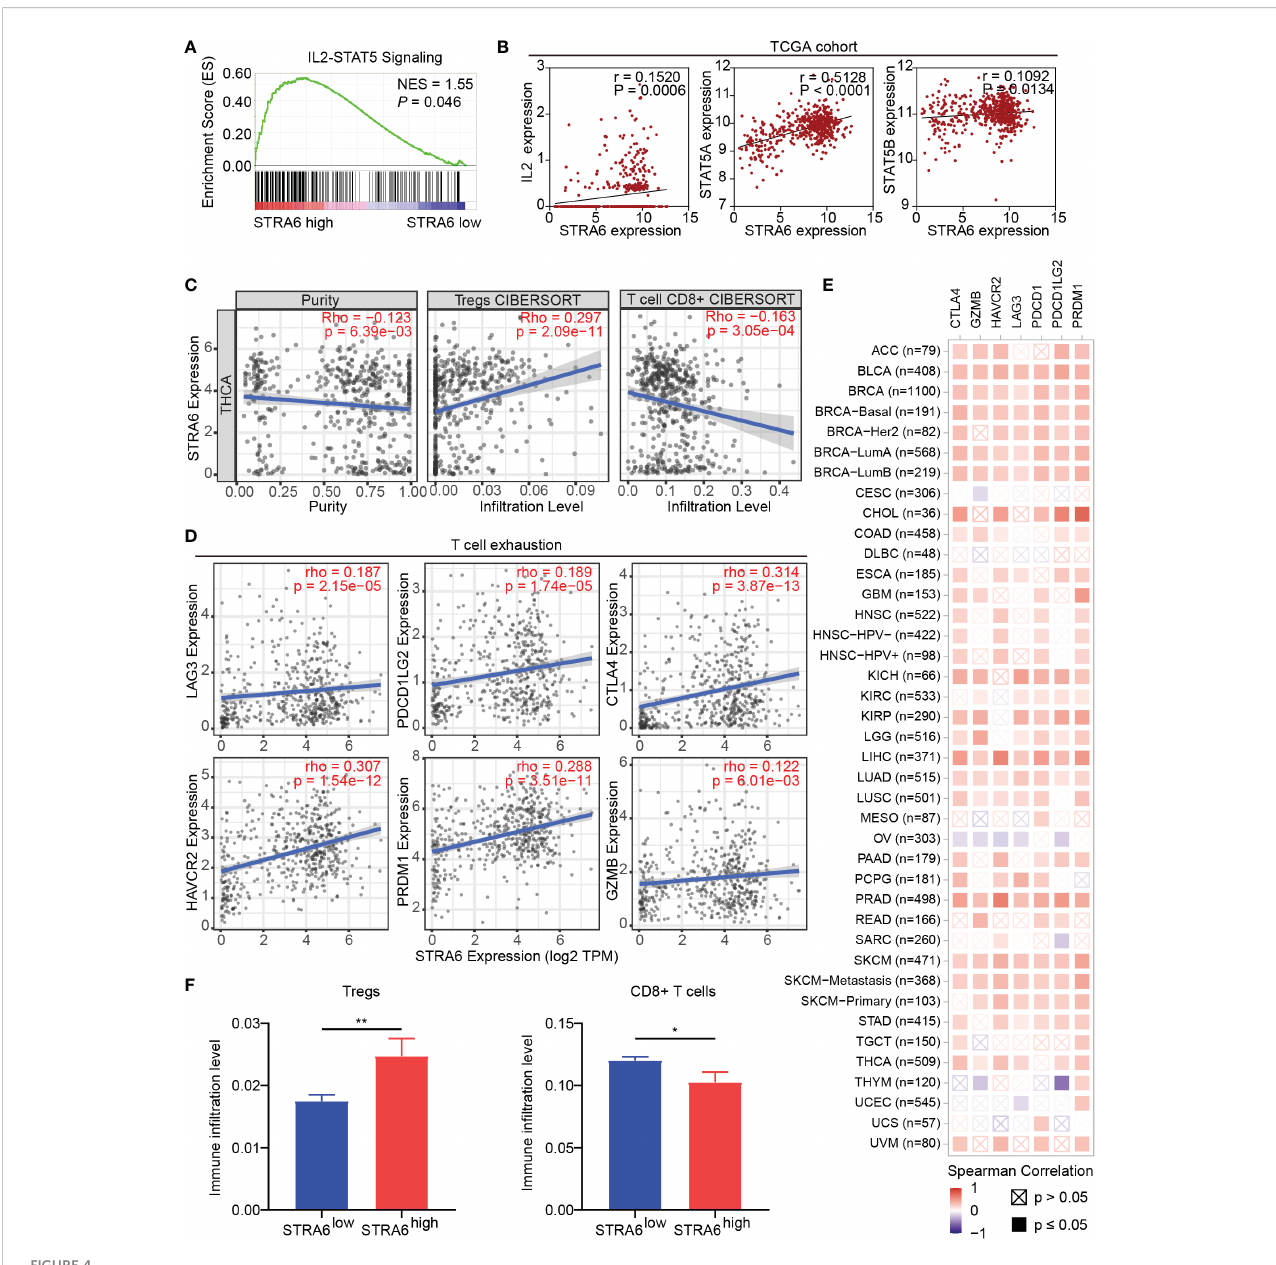
FIGURE 4 STRA6 regulates immunosuppressive microenvironment via the IL2-STAT5 signaling pathway. (A) Gene set enrichment analysis (GSEA) of the IL2-STAT5 signaling pathway enriched in samples with high-STRA6 expression. (B) Correlation of the expression of STRA6 and key molecules in the IL2-STAT5 pathway. (C) The correlation of STRA6 expression with in fi ltration of Tregs and CD8+ T cells according to the TCGA datasets. (D) Scatterplots of correlations between STRA6 expression and T cell exhaustion markers in the TCGA cohort. (E) Spearman correlations between STRA6 expression and T cell exhaustion markers in pan-cancer. (F) Immune in fi ltration level of Tregs and CD8+ T cells in PTC based on STRA6 expression. (*p < 0.05, **p < 0.01. The data are shown as the mean ±